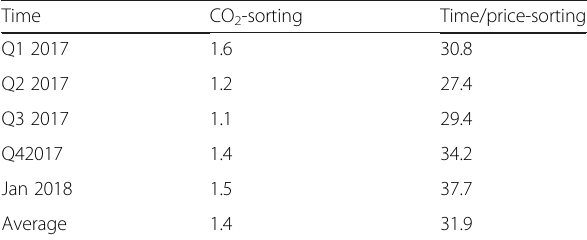
Source: Google Analytics